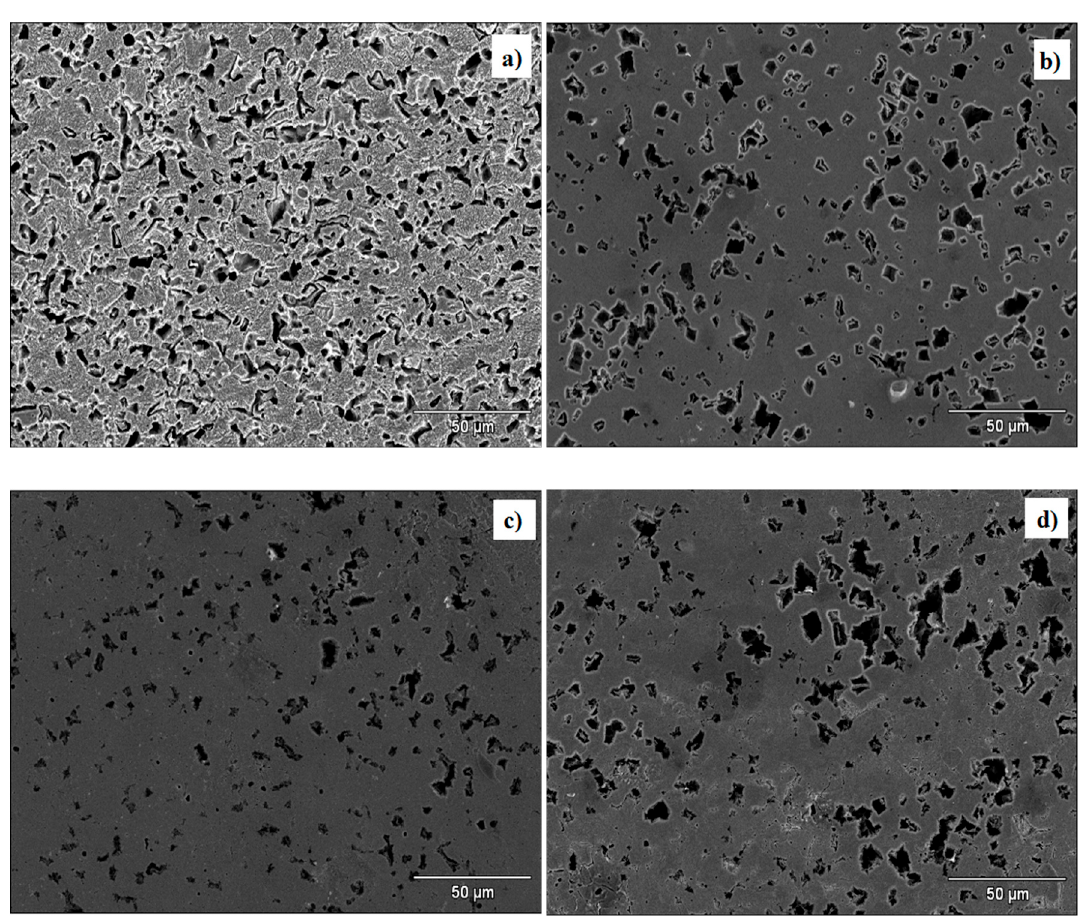
Figure 14. SEM micrographs of API 5L X60 steel exposed to 1 M H 2 SO 4 at 308 K in the presence of: ( a ) 0 ppm de PIL, ( b ) 175 ppm of Poly[VIMC4][Im], ( c ) 175 ppm of Poly[VIMC2][Br] and ( d ) 175 ppm of Poly[VIMC4][Br].